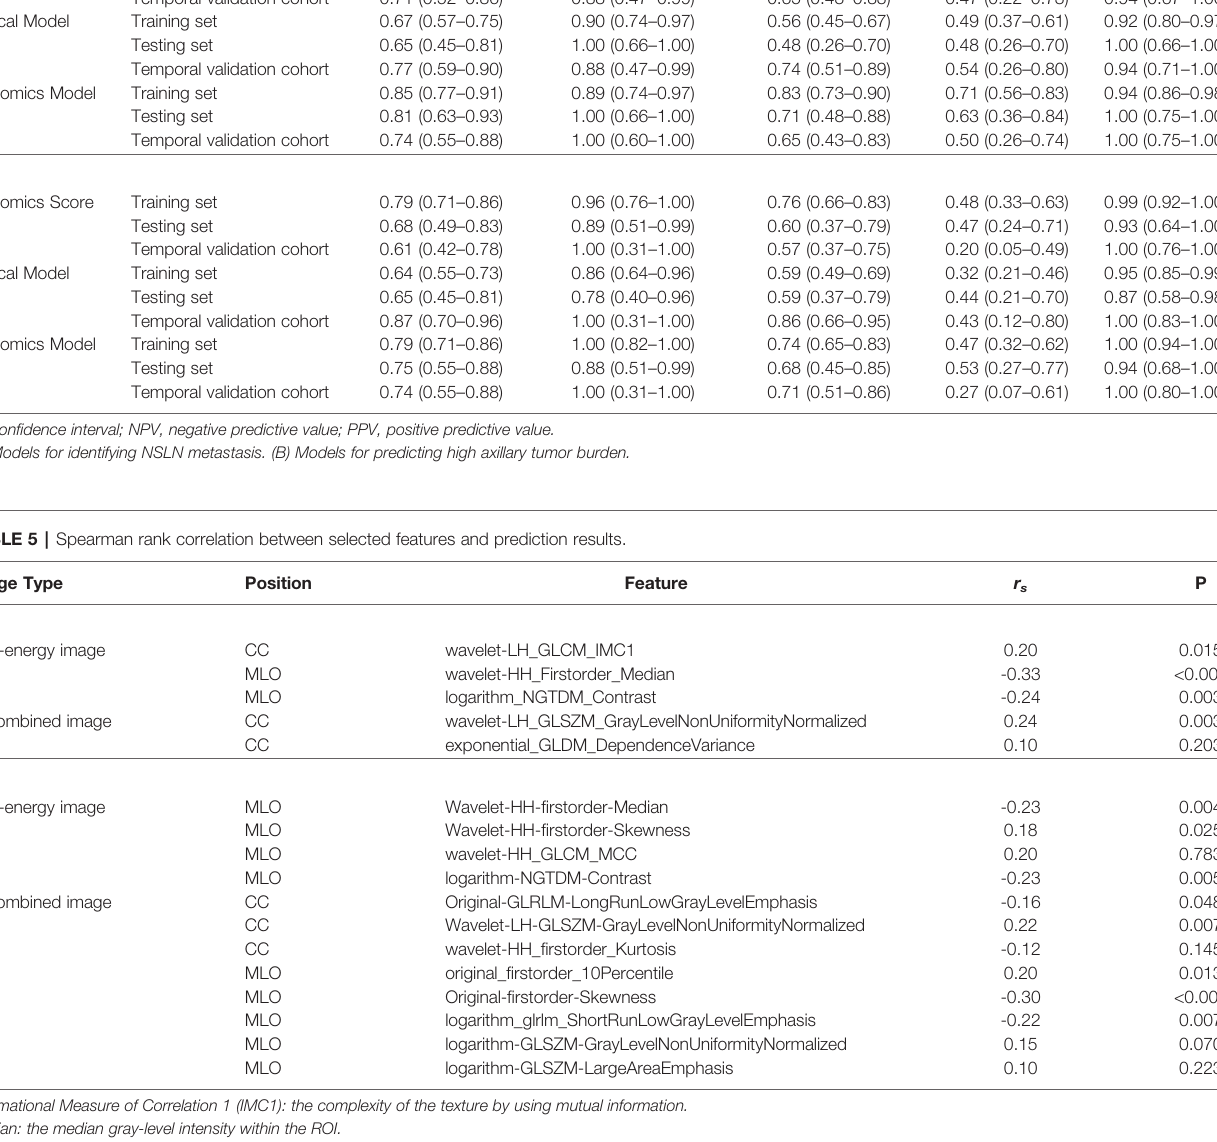
Table 4B summarized the prediction performance of different models, and the radiomics model outperformed the other models